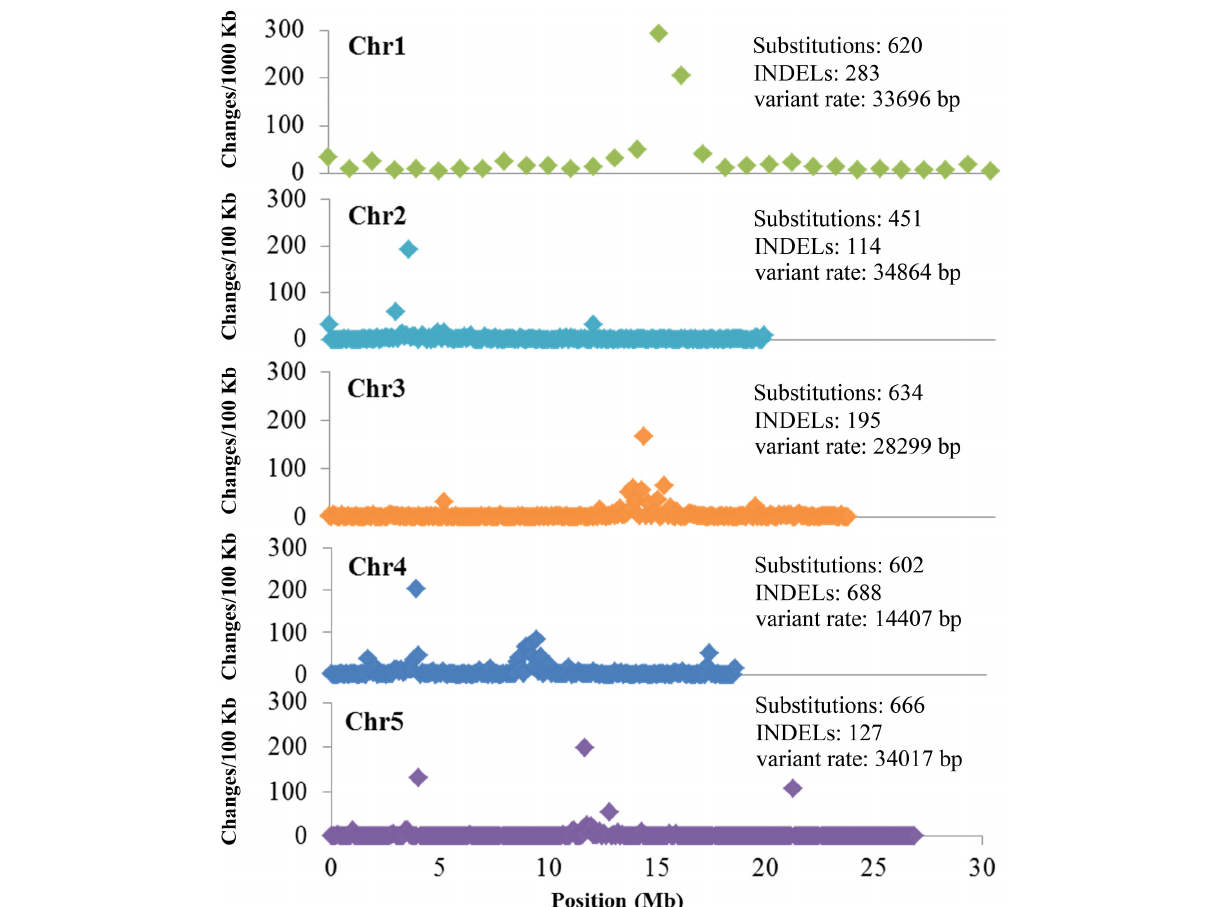
Frontiers in Plant Science |